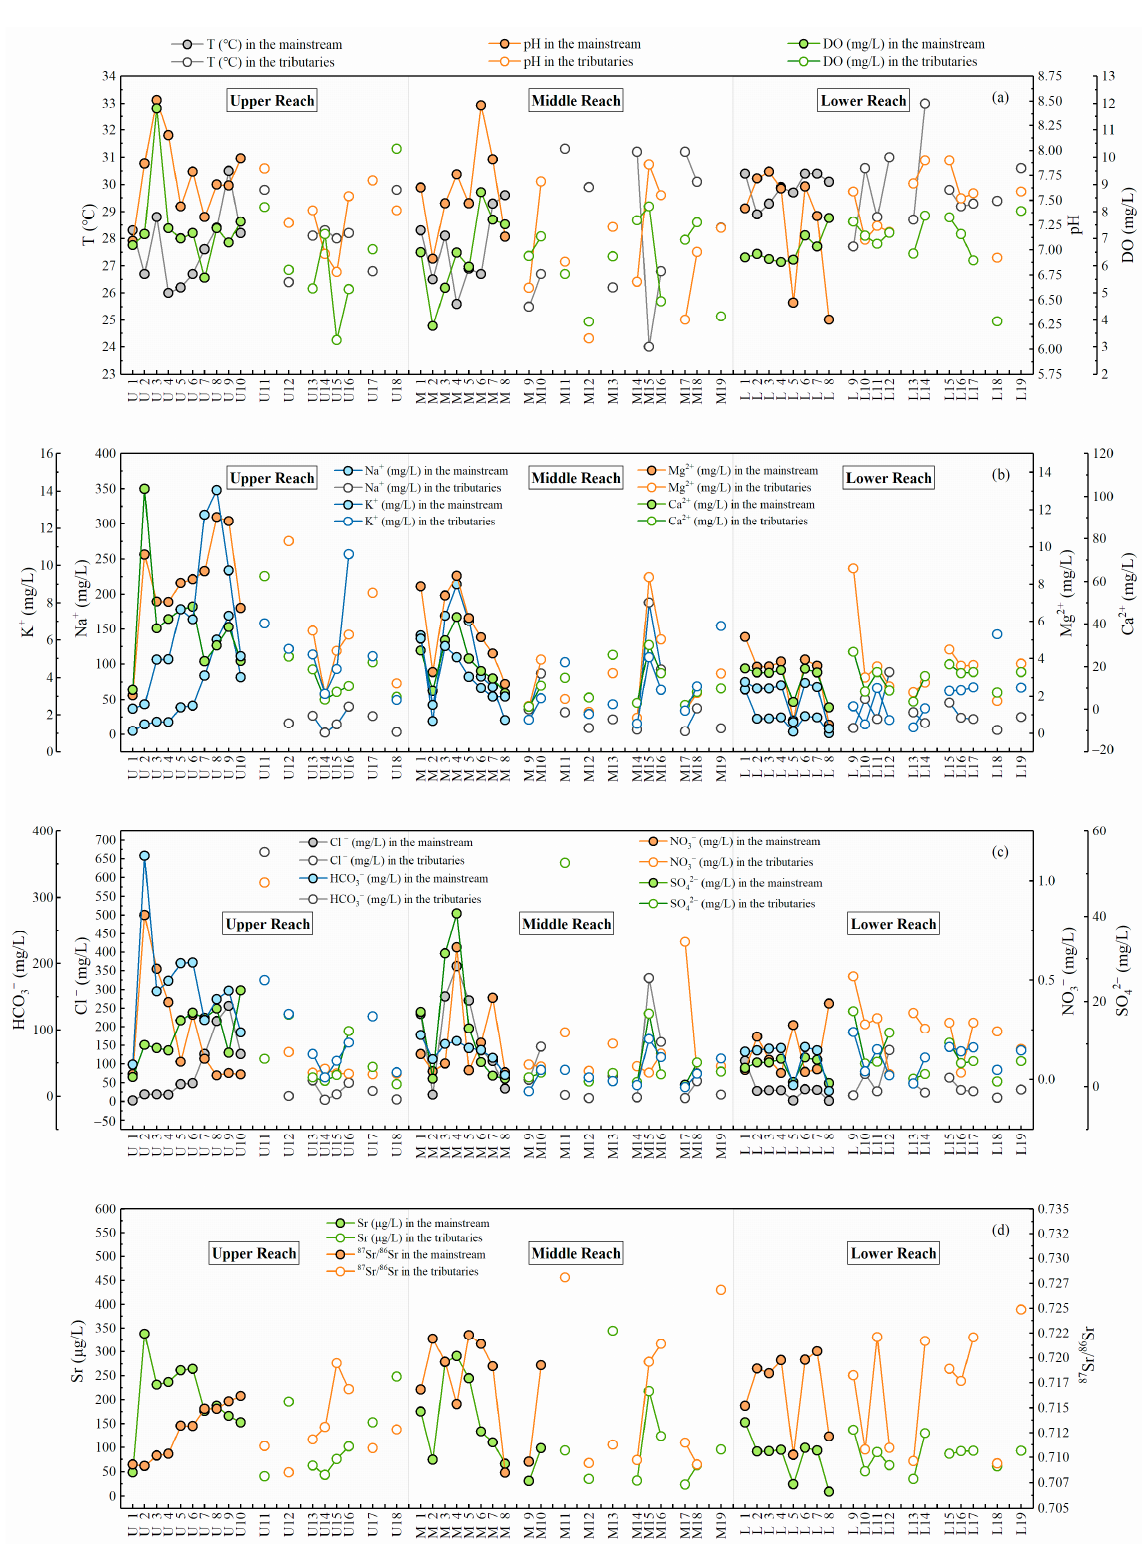
Figure 2. The spatial variation diagram of ( a ) temperature, pH, EC, and DO; ( b ) the concentration of major dissolved cations; ( c ) the concentration of major dissolved anions; ( d ) Sr concentration and 87 Sr/ 86 Sr in the Mun